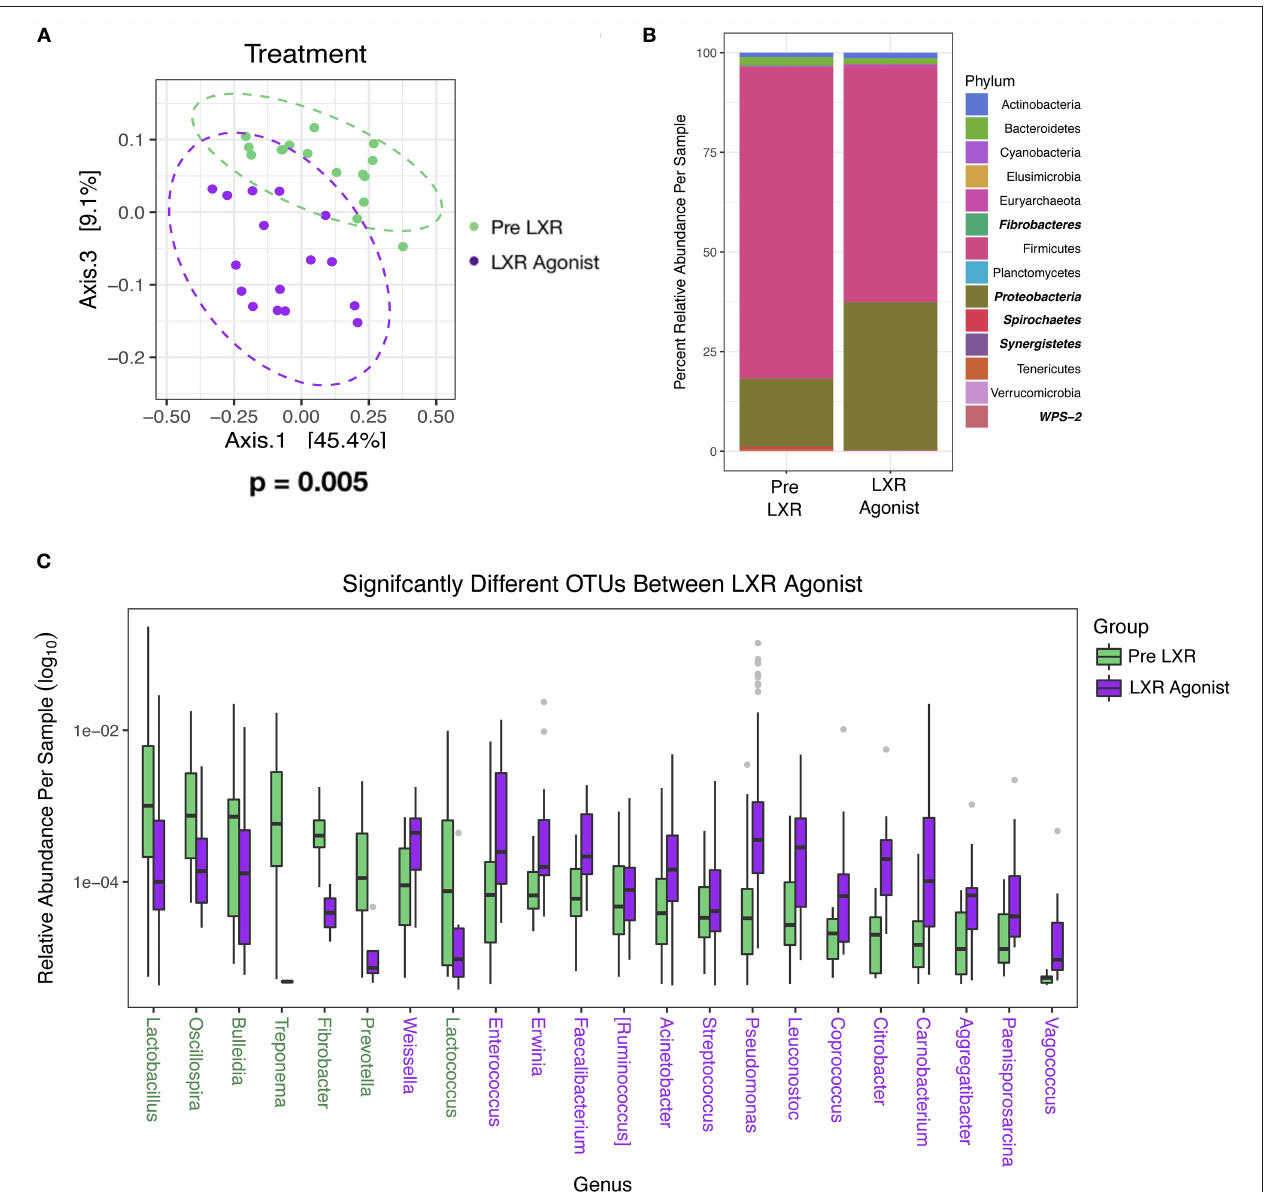
FIGURE 5 | The Lipid Homeostasis Study used IDOL ASO and LXR Agonist as treatments, and only the LXR Agonist affected the microbiome. Samples were plotted using principal coordinate analysis with weighted Unifrac distance, and groups were compared using non-parametric multivariate analysis of variance (PERMANOVA) Dashed ellipses represent 95% CI from the cluster centroid. (A) Differentially abundant phyla between diets were determined by DESeq2 using age and treatment as covariates and are bolded and italicized (B) , and differentially abundant OTUs were described at the genus level (C) . Legend colors are listed in order corresponding to the ordering with the bars. If colors are missing, then the relative abundance values are too small to be visible. Colored taxa names refer to which treatment the abundance was